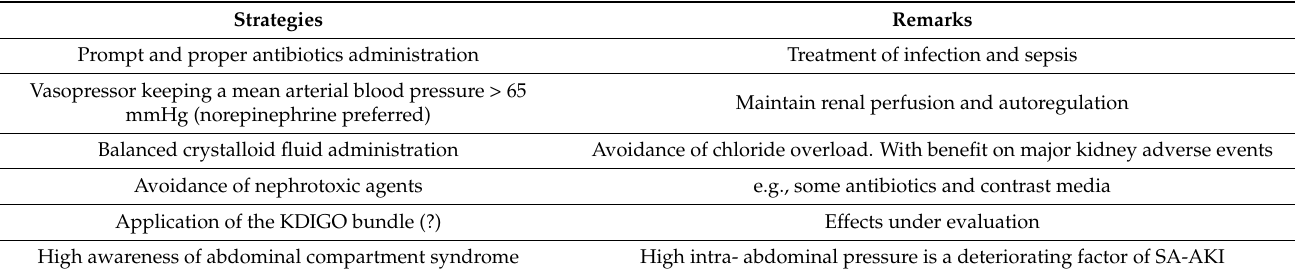
Table 1. Potentially preventive strategies for SA-AKI.